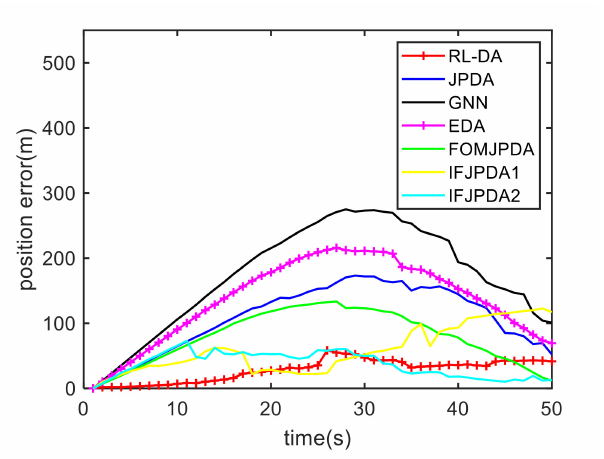
Figure 22. Comparison of the position errors for Target 2 in Case 1.